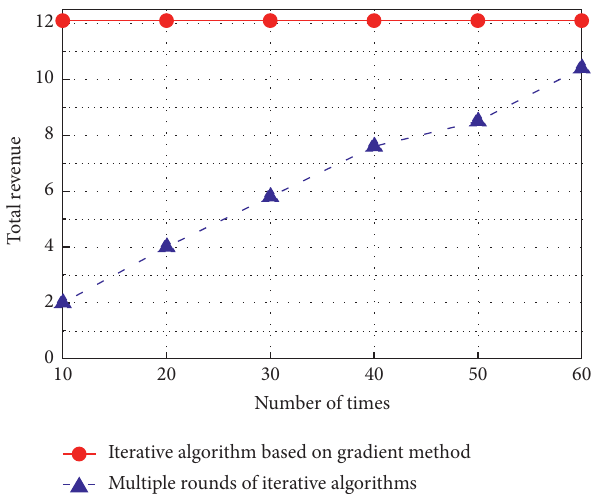
Figure 9: Comparison of the convergence speed of different